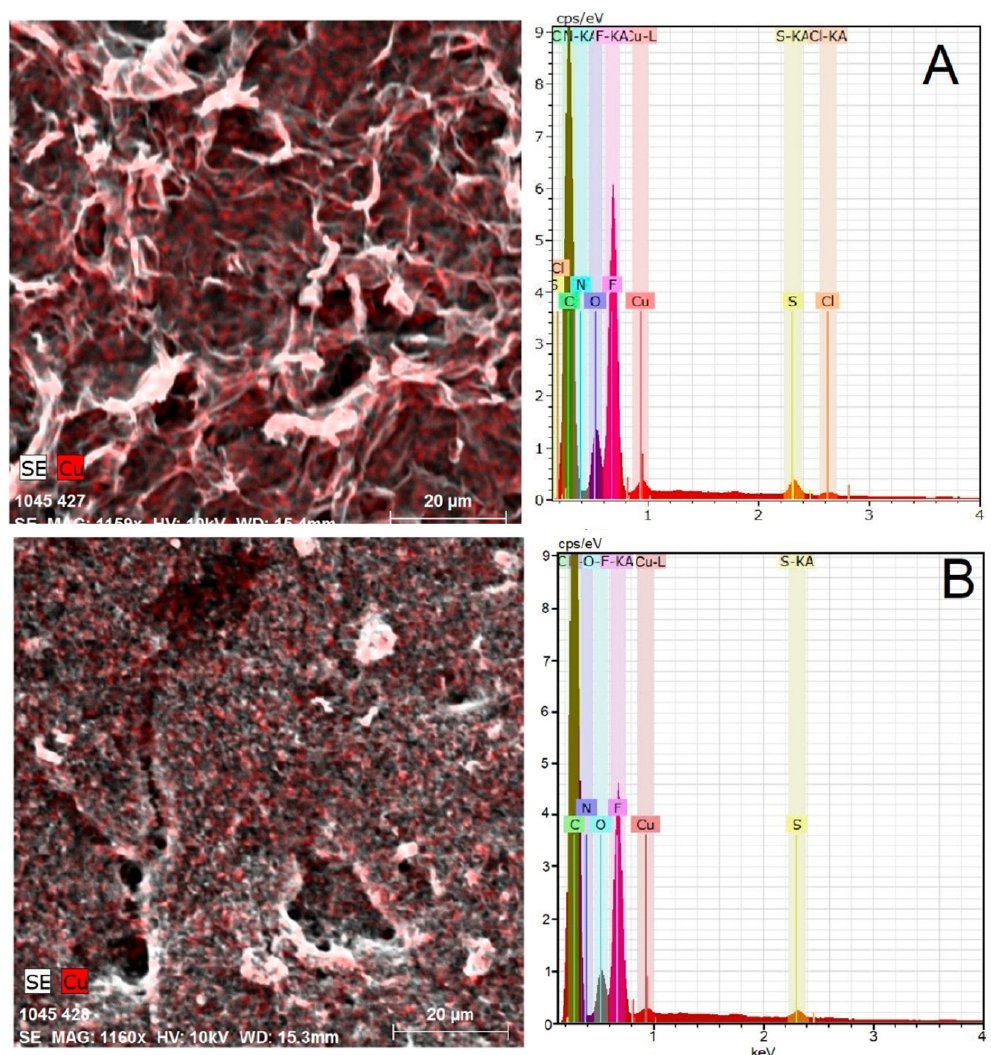
Figure 2. Elemental mapping of rGO ( A ) and MWCNTs ( B ) Elemental mapping of MWCNTs layers covered by Nafion ® membrane containing the [Cu(bipy) 2 Cl]Cl · 5H 2 O complex using SEM-EDX